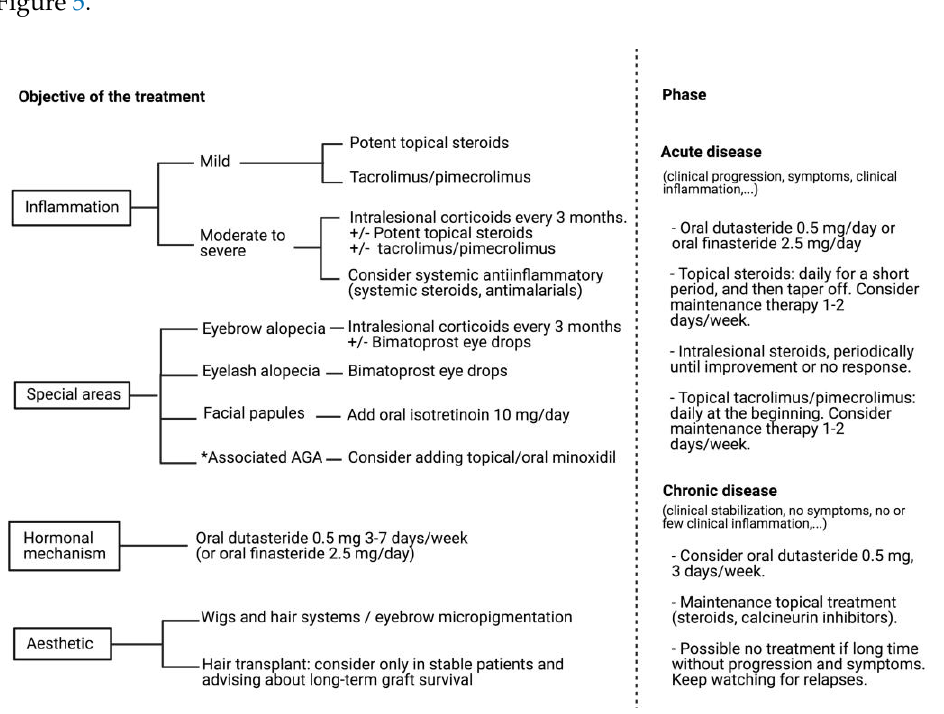
Figure 5. Algorithm of treatment. * Some patients with FFA may associate AGA; in these cases, adding minoxidil may provide an additional therapeutic benefit. Created with BioRender.com (accessed on 1 March